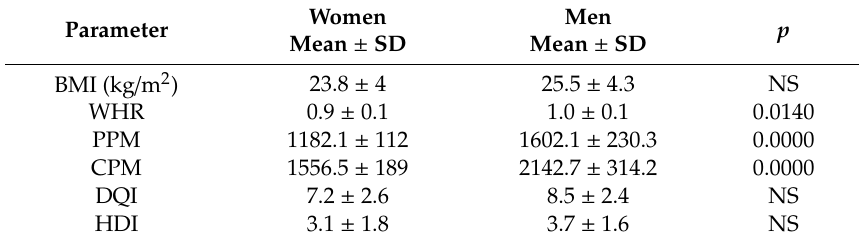
Table 3. The anthropometric indexes of GEP-NET patients with quality diet index with gender